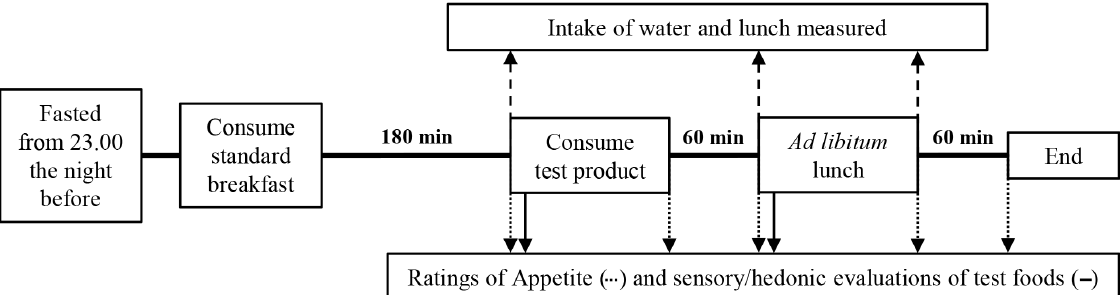
Figure 2. Schematic summary of the test day procedure. doi:10.1371/journal.pone.0100406.g002 PLOS ONE |